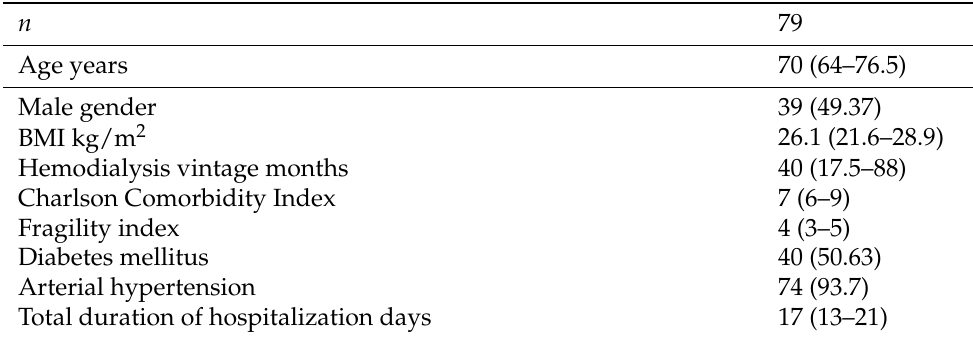
Table 1. Characteristics of study